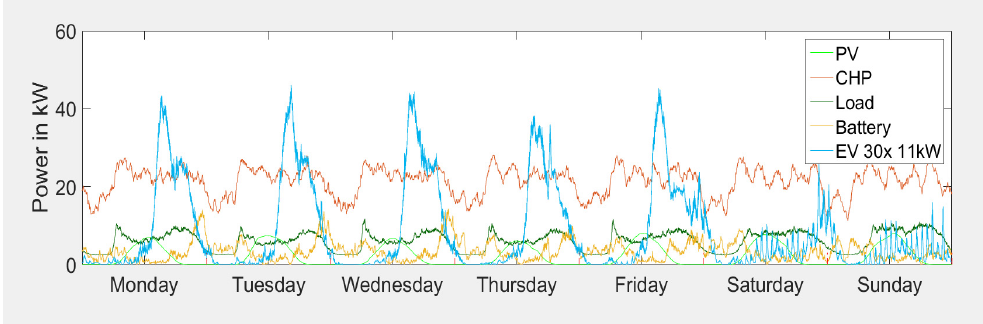
Figure 3. Load simulation results for scenario S4 with a self-consumption maximising battery operation strategy. Average day profiles from Monday to Sunday for CHP (orange) and PV (dark blue) power production, household (green) and EV (blue) power consumption, battery charging (yellow).